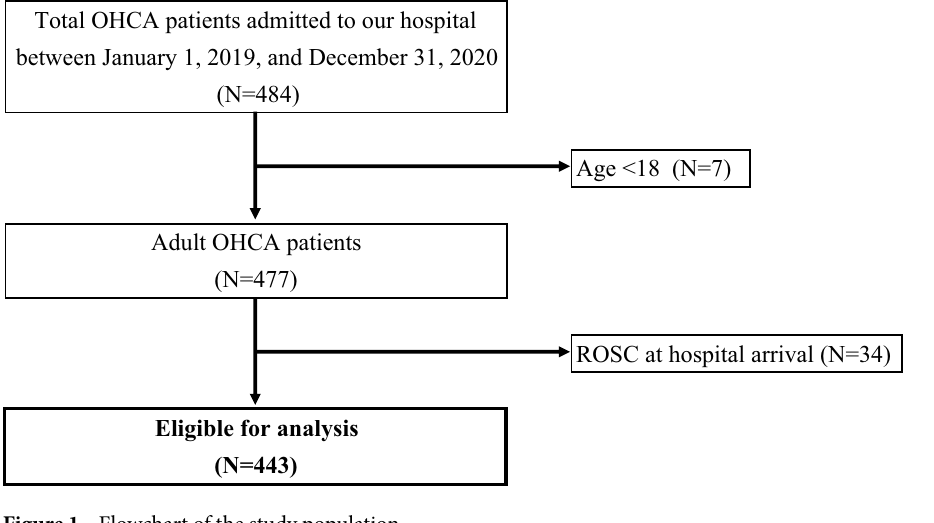
Figure 1. Flowchart of the study